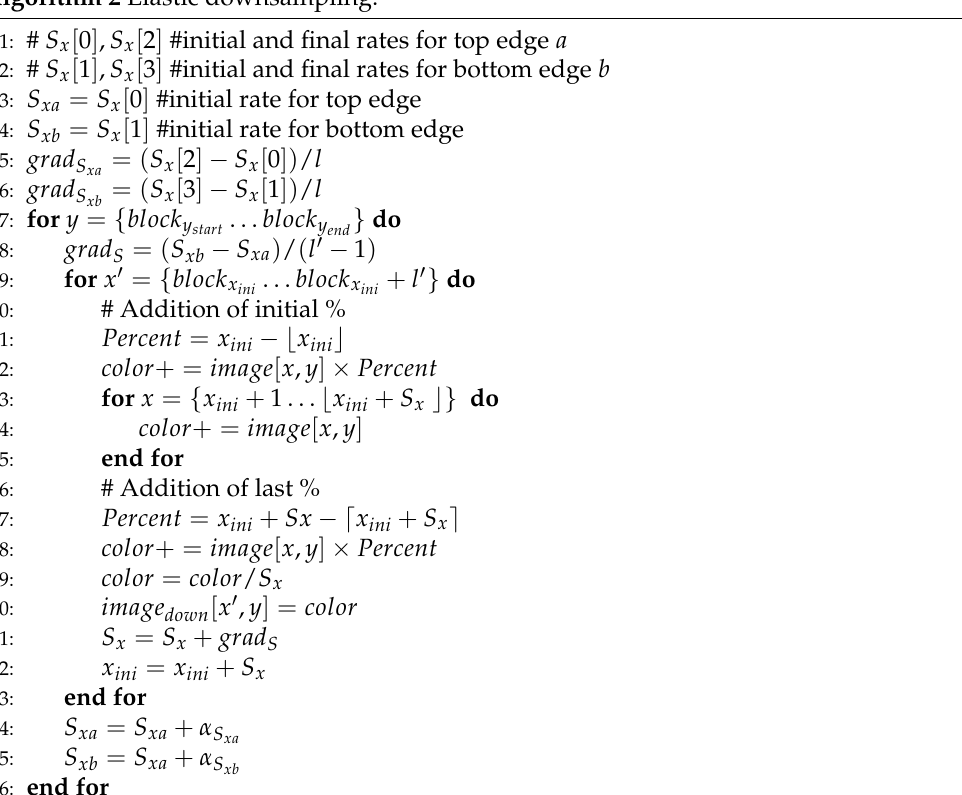
Algorithm 2 Elastic downsampling.